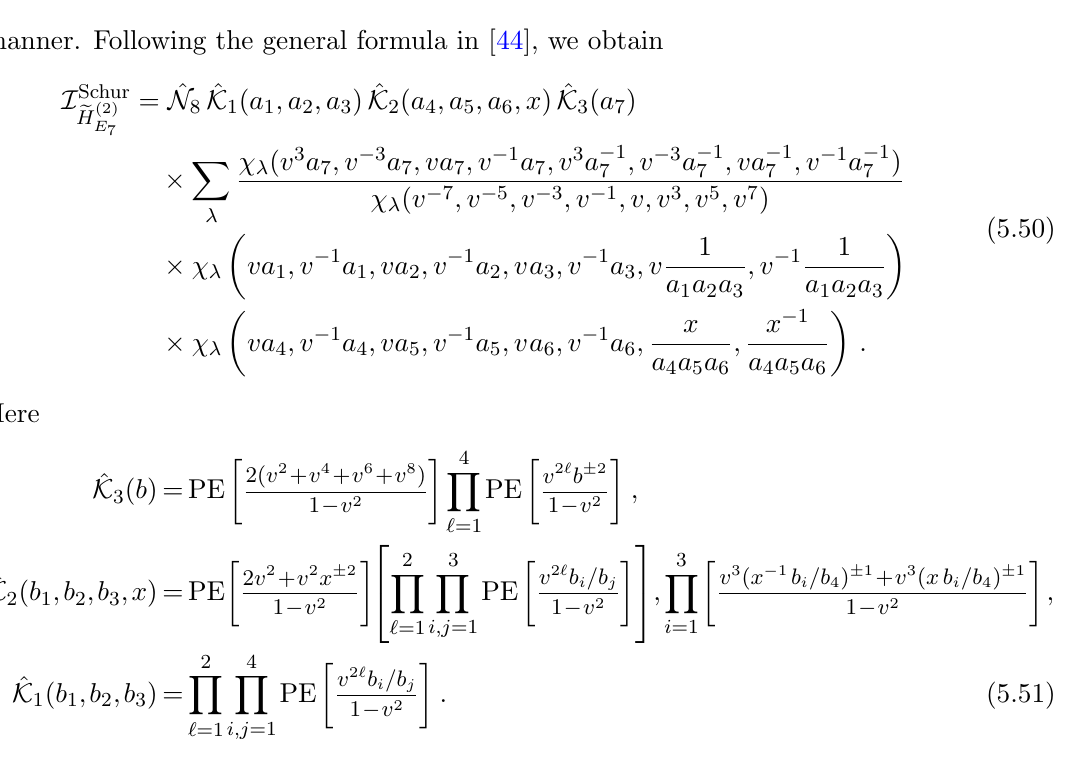
manner. Following the general formula in [44], we